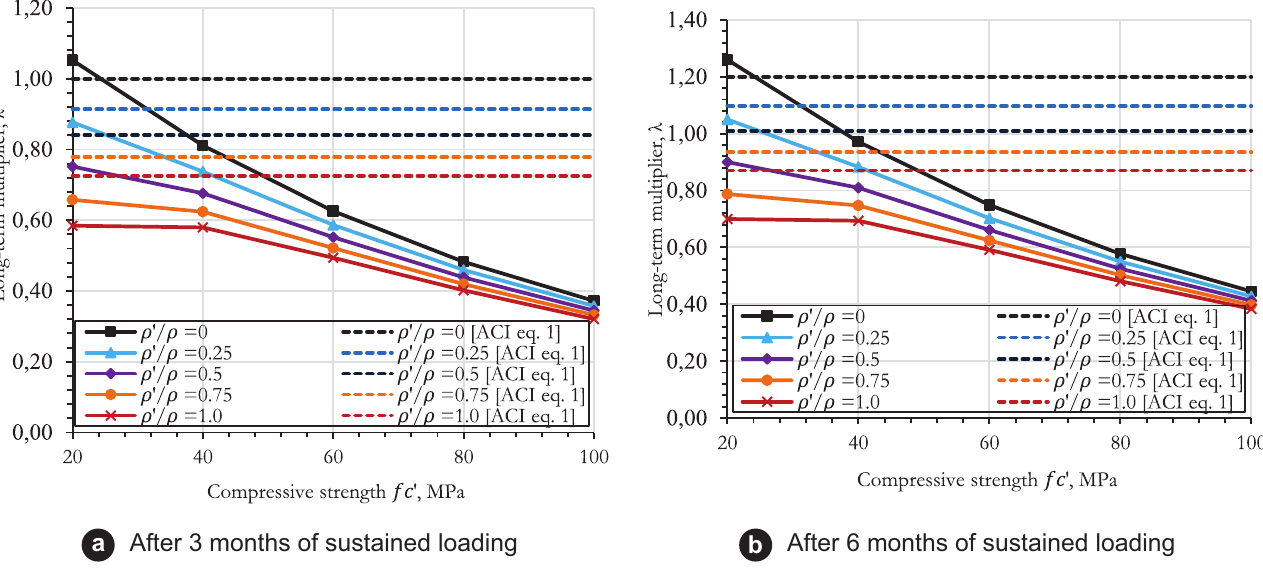
a After 3 months of sustained loading b After 6 months of sustained loading Figure 3 Effects of the ratio between compressive to tensile reinforcement ( r '/ r ) on the long-term deflection multiplier ( λ )